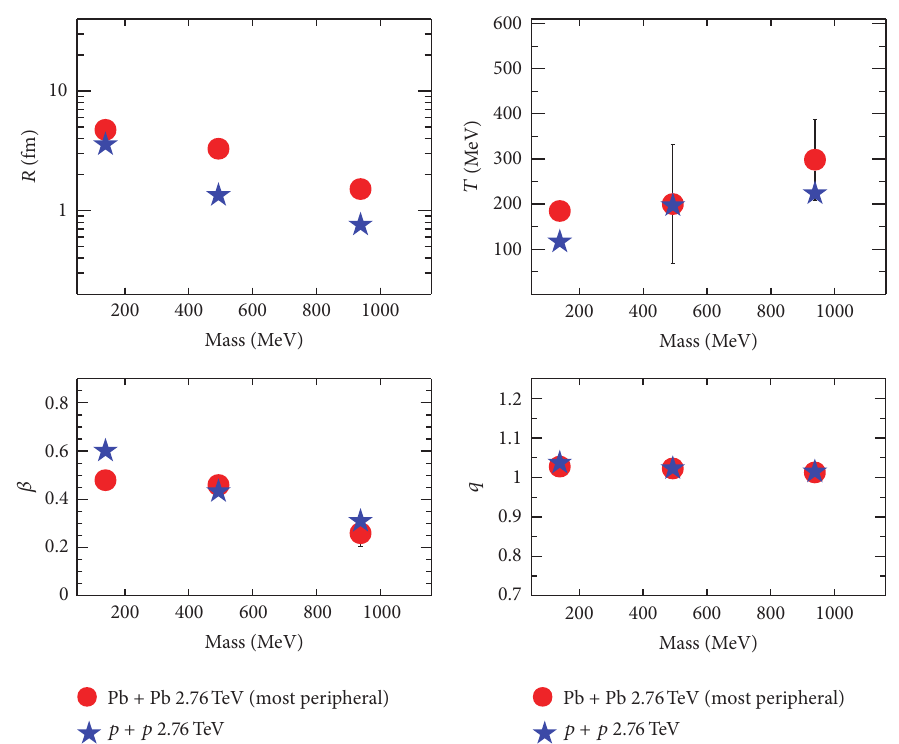
Figure10:MassdependenceofextractedthermodynamicparametersofTsallisdistributionincludingradialflowusing(8)formostperipheral Pb + Pb collisions and 𝑝 + 𝑝 collisions at √𝑠 NN = 2.76